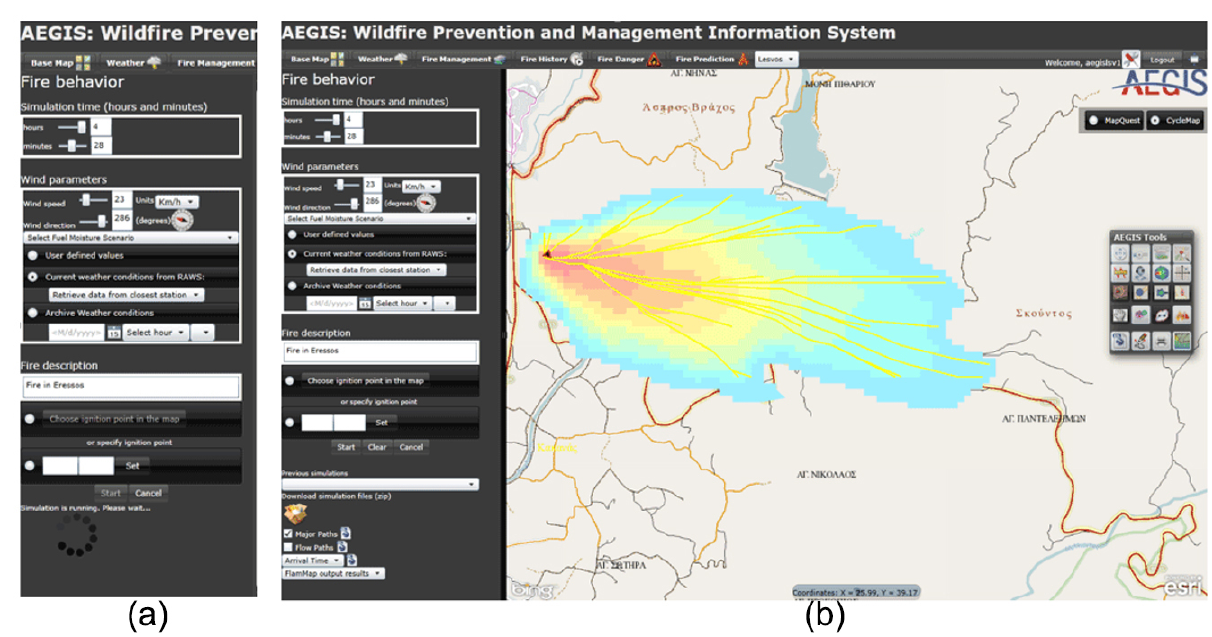
Figure 7. Visualization of a single fire simulation within the AEGIS graphical interface.